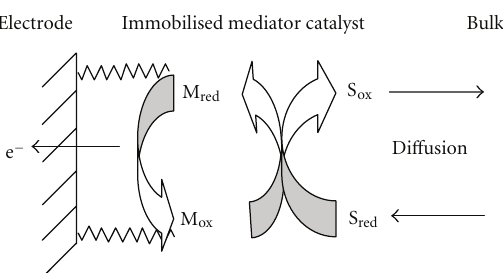
Figure 1: Electrocatalysis at modified electrode. M: mediator, S: